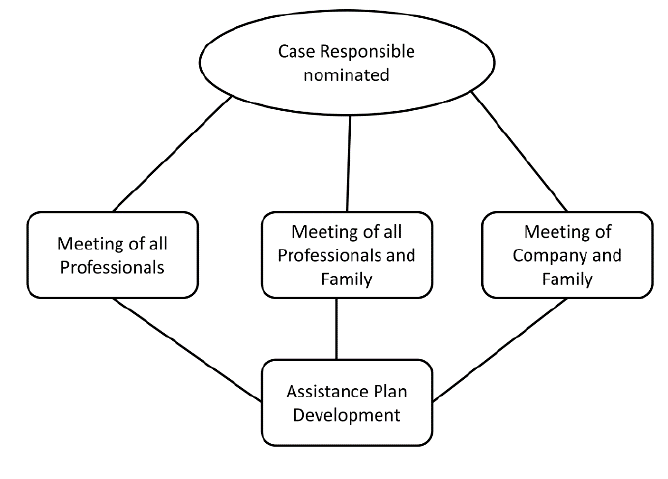
Figure 4. Part of initial model (1st